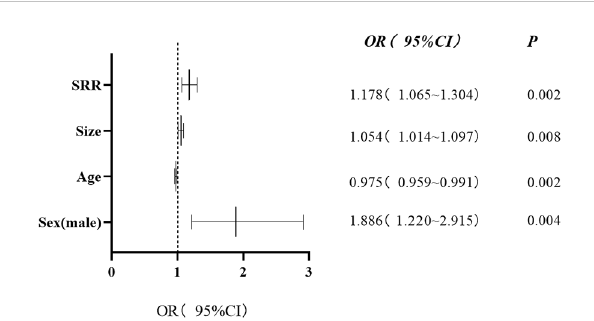
FIGURE 6 Forest plot showing the results of multivariate regression analysis. Four independent risk factors of occult central cervical lymph nodes metastasis were identi fi ed. The x-axis shows the relative odds ratio (OR) and 95% con fi dence interval (CI) of each covariate. OR (95% CI) and P values are presented on the right. SRR, strain rate